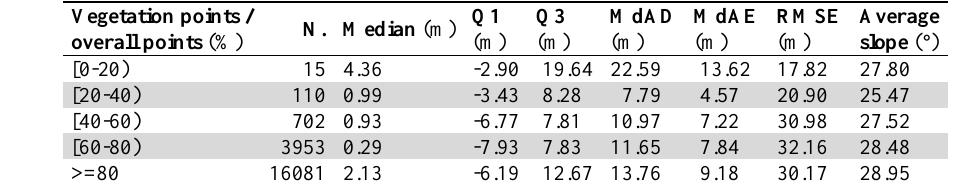
Table. A.1.4. Statistics related to errors from GEDI vs terrain height from discrete lidar divided in classes related to the fraction of points belonging to vegetation over the total points from the discrete lidar